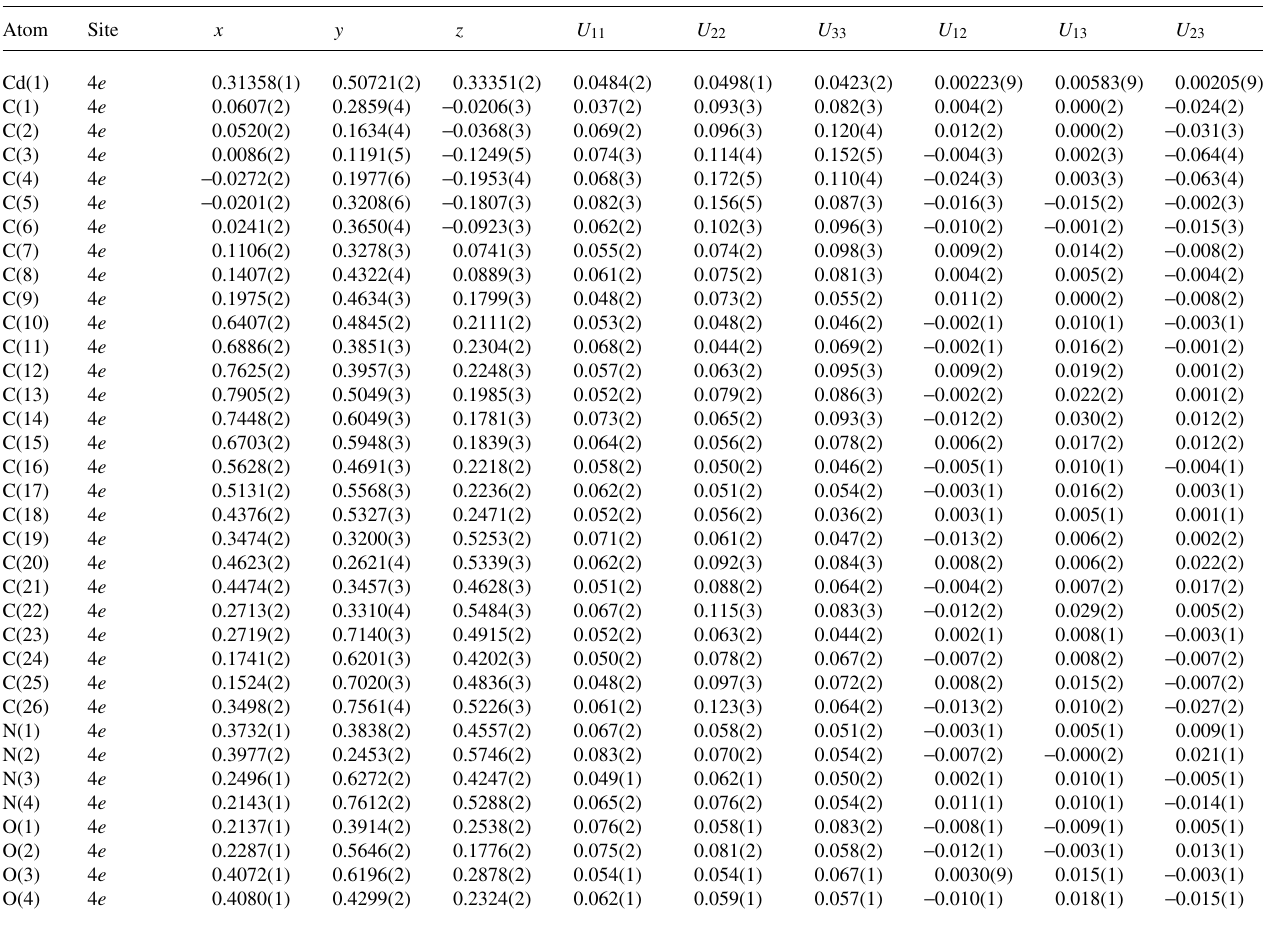
Table 3. Atomic coordinates and displacement parameters (in Å 2 )